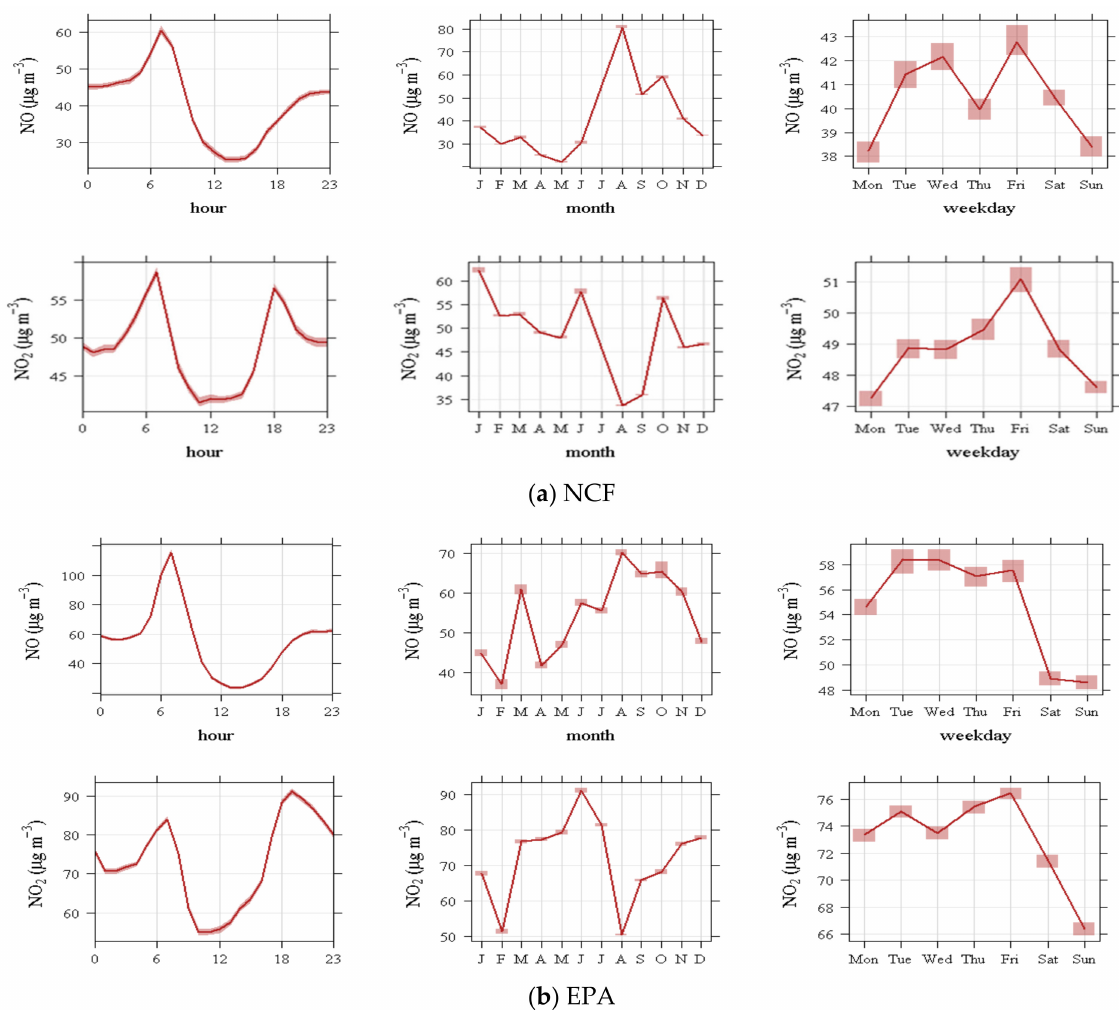
Figure 4. Example average concentrations at NCF and EPA for NO and NO 2 for the duration of the study. Graphs in ( a ) are NCF and ( b ) are EPA sites. The remaining site data are located in Figures